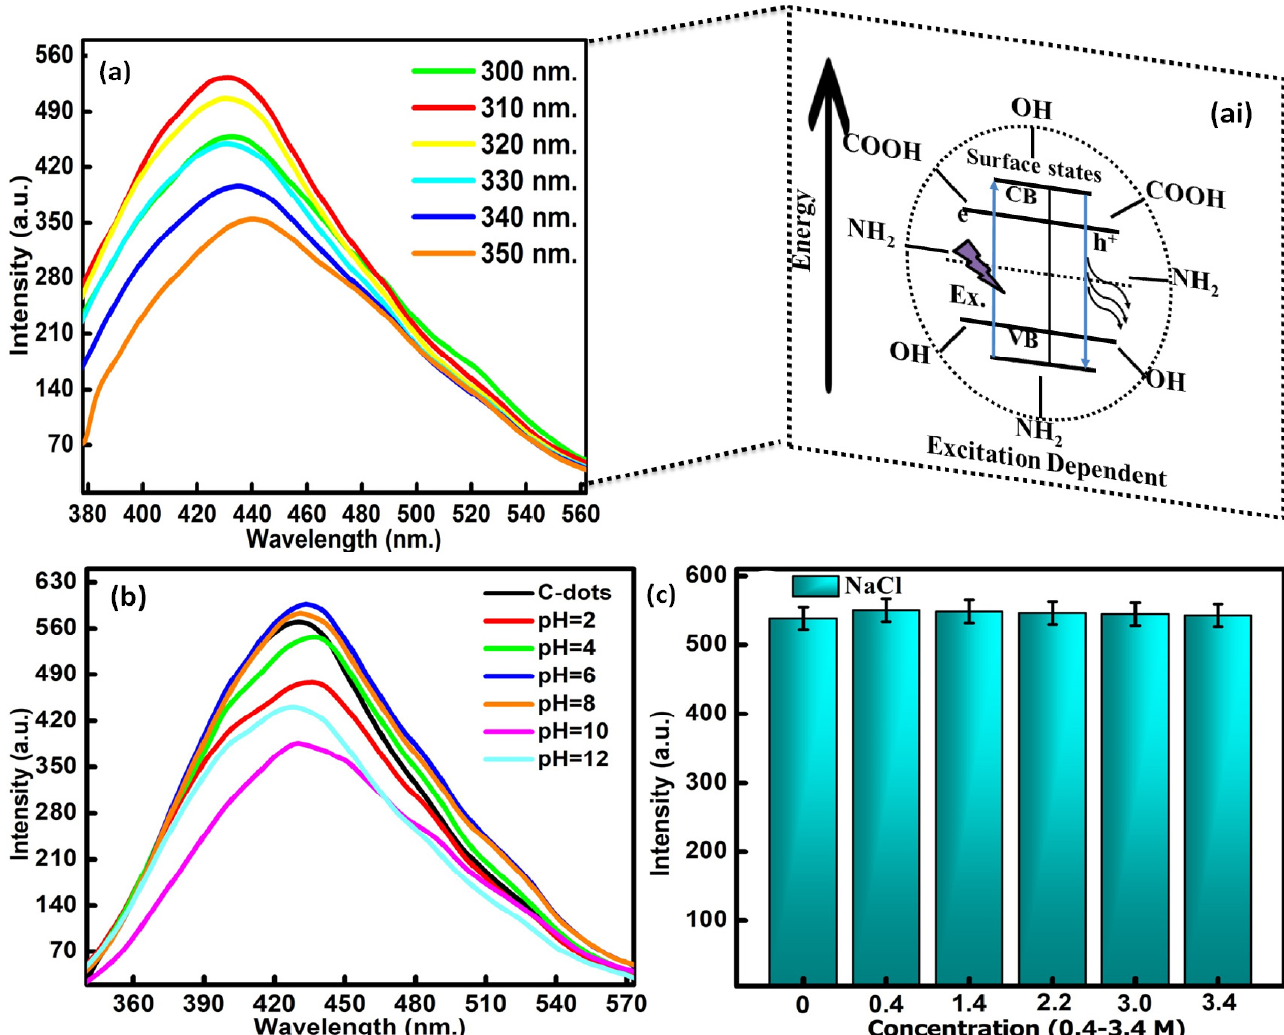
Figure 3. ( a ) Fluorescence emission spectra at different excitation wavelengths, ( ai ) mechanistic behavior of emission profile CQDs, ( b ) pH-dependent emission profile and ( c ) effect of ionic strength on the emission intensity of CQDs.